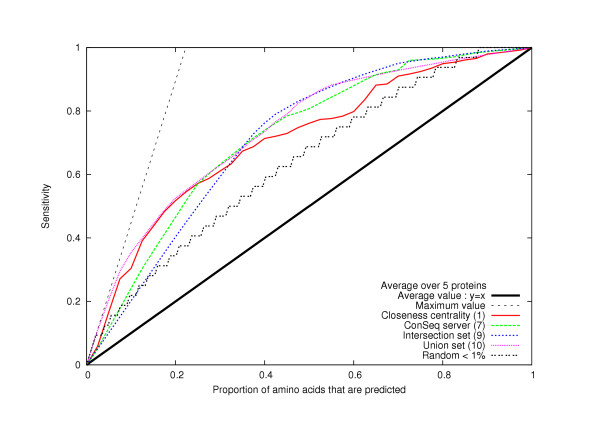
A new method for essential amino acid prediction. We compare the new method (based on the two sets of amino acids Union and Intersection) with method 1 (based on closeness centrality) and the Conseq server. This method is better than the others: indeed, if we predict fewer than 35% of the amino acids, then the curve (9) is, over most of that range, the highest one; if we predict more than 60% of the amino acids, the curve (10) is, over most of that range, the highest. The calculations are made as an average over the five networks representing HIV-1 protease, TEM1 beta-lactamase, T4 lysozyme, Barnase and the bacteriophage f1 gene V protein.